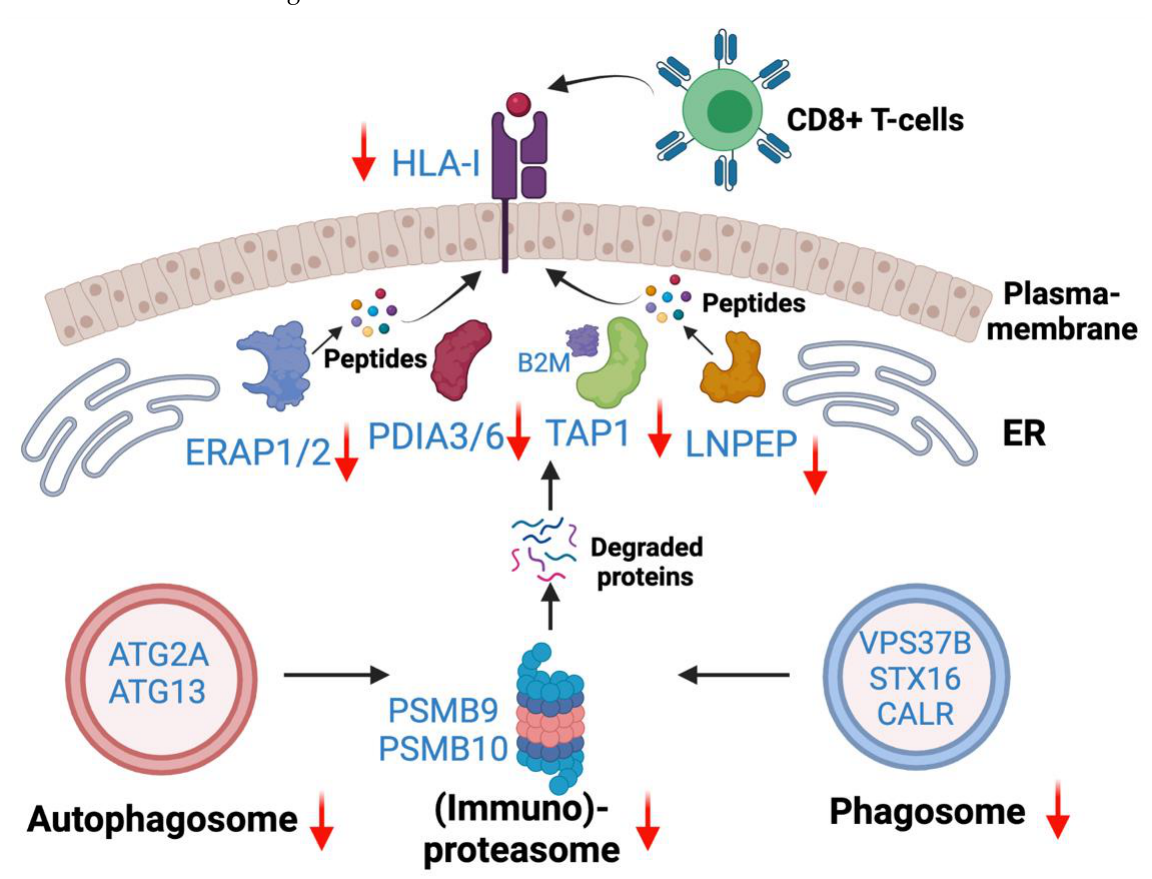
Figure 10. Antigen generation and HLA Class—I associated antigen presentation signaling pathway. Down-regulated autophagosome, immunoproteasome, phagosome were main avenues to generate degraded protein (e.g., antigen). Down- regulated HLA-I complex and peptidases contribute to reduced antigen presentation in OsiR.